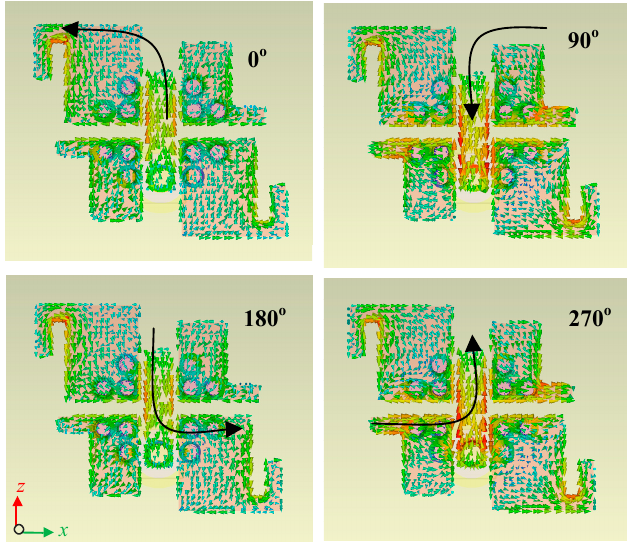
Figure 3. Surface current distributions of the proposed CP ME dipole antenna for different time phases at 28 GHz.